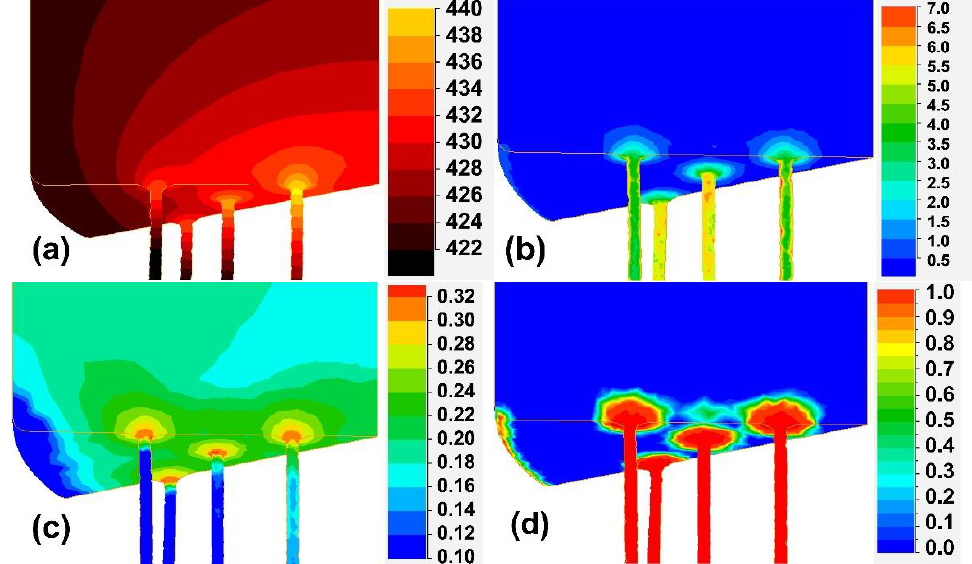
Figure 4. An exemplary result of the simulation, the extrusion velocity of 0.25 mm/s, the initial billet temperature equal to 400 °С: the distribution of temperature ( a ), effective plastic true strain ( b ), critical deformation, calculated by Equation (5) ( c ), and the dynamically recrystallized volume fraction ( d ).